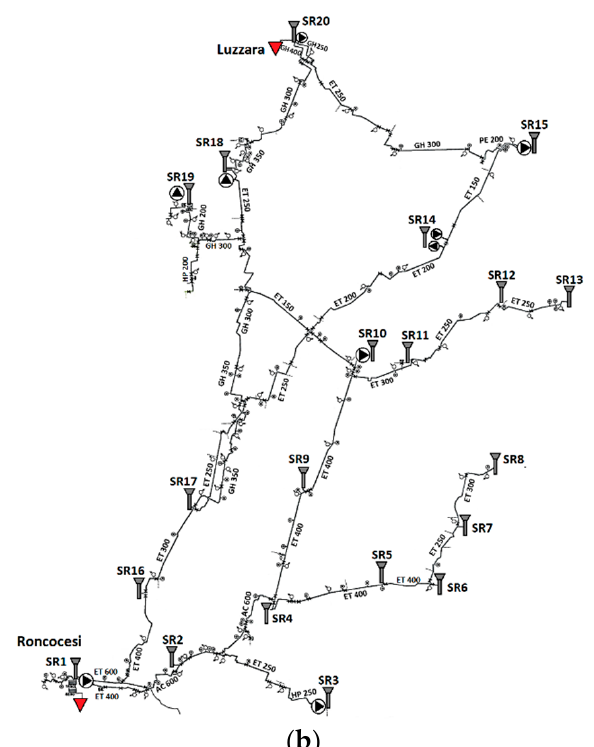
Figure 3. ( a ) Districts served by Roncocesi and Luzzara networks; ( b ) Schematization of Roncocesi and Luzzara networks, with main components. Table 1. Inhabitants served by Roncocesi and Luzzara water networks from 2012 to 2014. WSN